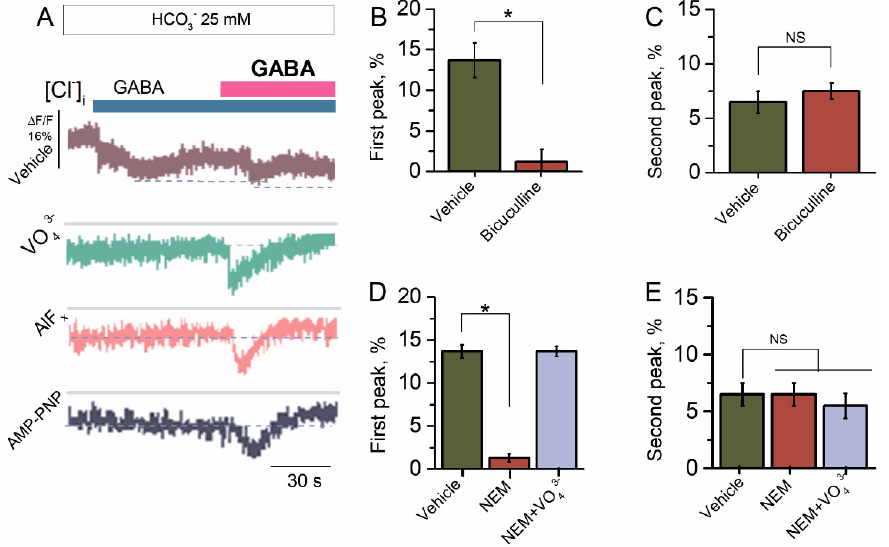
Figure 2. Bicarbonate hindered the desensitization of GABA A R-mediated Cl − influx. ( A ) Representa- tive images of MQAE fluorescence changes in SNs recorded in response to first application of GABA (100 μ M) and reapplication of GABA (100 μ M) in the presence of HCO 3 − (25 mM) in an experimental medium, without or in the presence of VO 43 − (20 μ M), AlF x (10 μ M), or AMP-PNP (2 mM). ( B ) Bar graph of percentage in MQAE peak fluorescence changes in response to first application of GABA (100 μ M), without or in the presence of bicuculline (50 μ M) (one-way ANOVA, Tukey’s test: F (6,9) = 47.5, р = 0.00075, n = 7). ( C ) Bar graph of percentage in MQAE peak fluorescence changes in response to reapplication of GABA (100 μ M), without or in the presence of bicuculline (50 μ M) (one-way ANOVA, Tukey’s test: F (6,9) = 1.5, р = 0.05, n = 7). ( D ) Bar graph of percentage in MQAE peak fluo- rescence changes in response to first application of GABA (100 μ M) without or containing NEM (300 μ M), in the absence or presence of VO 43 − (20 μ M) in an experimental medium (one-way ANOVA, Tukey’s test: F (9,6) = 23.7, р = 0.0005, n = 6 or F (9,6) = 0.01, р = 0.05, n = 6). ( E ) Bar graph of percentage in MQAE peak fluorescence changes in response to reapplication of GABA (100 μ M) without or containing NEM (300 μ M), in the absence or presence of VO 43 − (20 μ M) in an experimental medium (one-way ANOVA, Tukey’s test: F (9,6) = 0.13, р = 0.05, n = 6 or F (9,6) = 0.4, р = 0.05, n = 6). All data in the bar graphs in this figure and those proceeding it are presented as mean values +/ − SEM; * р < 0.05. 2.3. ATP-Dependent Recovery of GABA A R-Mediated pH i Changes The rat hippocampal pyramidal neurons show an instantaneous net influx of Cl − and efflux of HCO 3 − in response to GABA (500 μ M) application with a subsequent steady-state decrease in intracellular pH (pH i ) of 0.2 to 0.5 [41,42]. To explore the GABA A R-mediated HCO 3 − outflux, the SNs initially were loaded with dye for pH i (BCECF) before being ex- posed to GABA (100 μ M). Since at reapplication of the same concentration of GABA (100 μ M) [43,44], the GABA A Rs are permeable to HCO 3 − , we studied the change in the pH i in the SNs after the first and repeated application of GABA (100 μ M) in the presence of HCO 3 − (25 mM). Here, similar results were observed, where SNs quickly demonstrated a pH i decrease for both the first and repetitive application of the agonist with a maximum peak of fluorescence changes of 15.5 ± 1.5% ( n = 6) and 12.0 ± 1.0% ( n = 6), respectively (Figure 3B ,C). These data showed the absence of desensitization and only appeared in the process of resensitization. To further elucidate the cause of pH i changes by GABA appli- cation, we added bicuculline to the experimental medium. Bicuculline (50 μ M) inhibited the GABA-mediated HCO 3 − outflux to first and repeated application of the agonist (Figure 3D,E). We added the γ PAs in the experimental medium to assess the role of ATPase in the recovery of GABA A R-mediated HCO 3 − outflux. All γ PAs eliminated the GABA-mediated pH i changes in the first and repeated application of the agonist (Figure 3A–C).